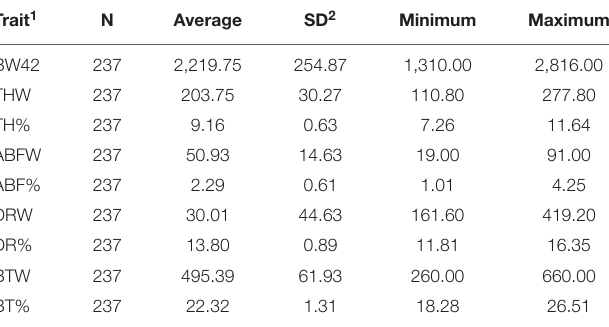
TABLE 2 | Number of animals (N), mean, standard deviation (SD), minimum and maximum values for carcass traits from animals utilized for single SNP association analysis in the TT Reference